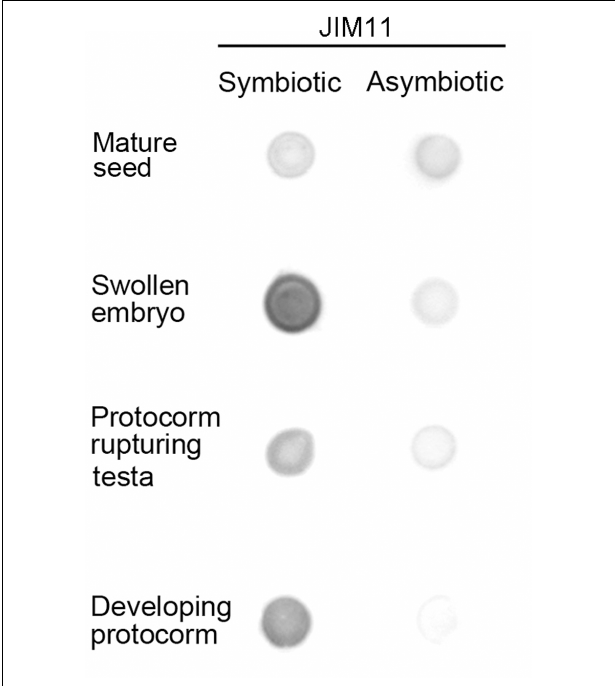
FIGURE 5 | Semi-quantitative analysis by immunodot blots of the relative abundance of JIM11 epitope in extracts prepared from the mature seeds and developing protocorms in the symbiotic and asymbiotic cultures.